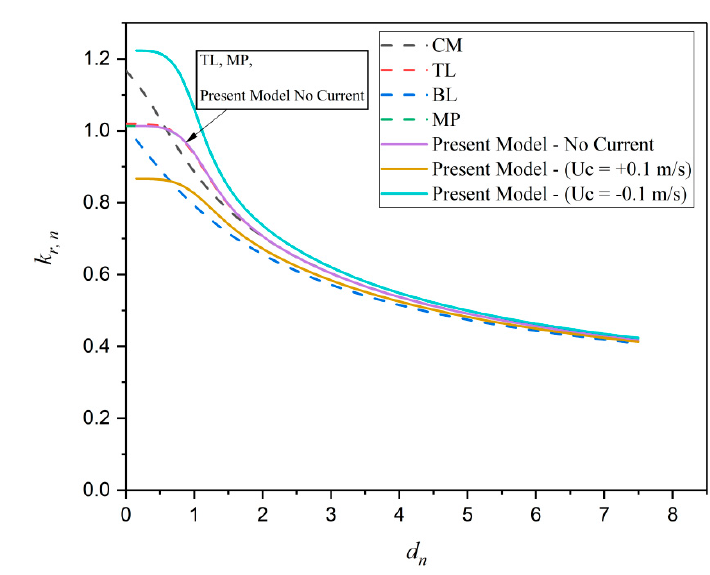
Figure 3. Wave number versus dimensionless mud thickness.